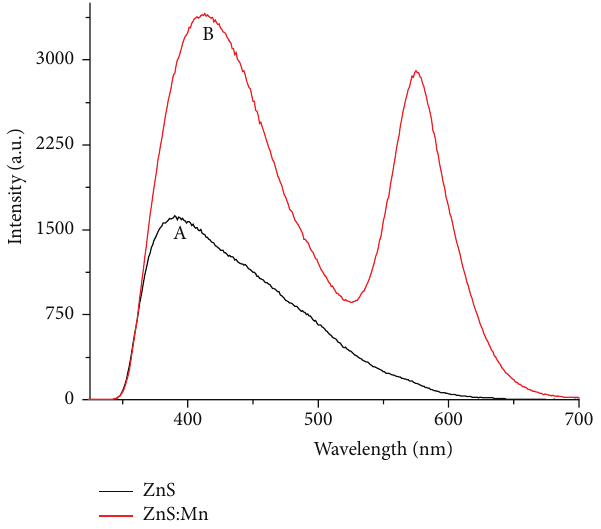
Figure2:FluorescenceemissionspectraofZnSandZnS:Mn 2+ QDs. The excitation wavelength for all the samples was fixed at 300 nm.